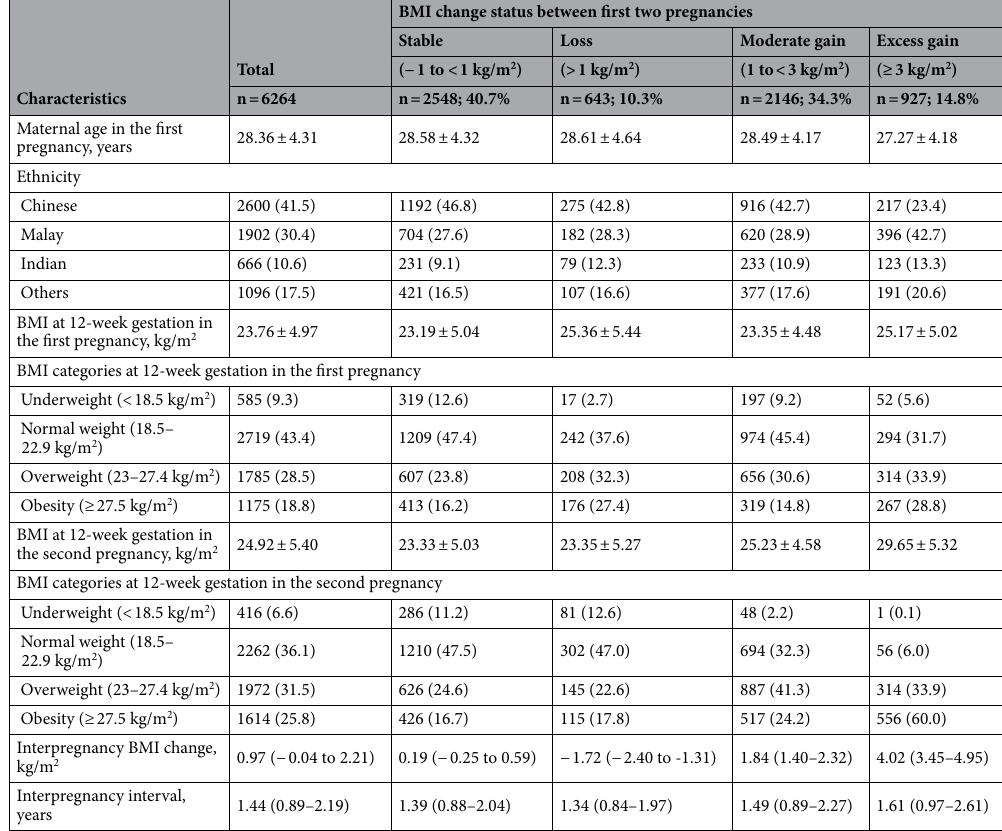
Table 1. Characteristics of participants according to their interpregnancy BMI change status (n = 6264). Data are presented as number (percentage) for categorical variables, and as mean ± standard deviation or median (25th–75th percentiles) for continuous variables. BMI, body mass